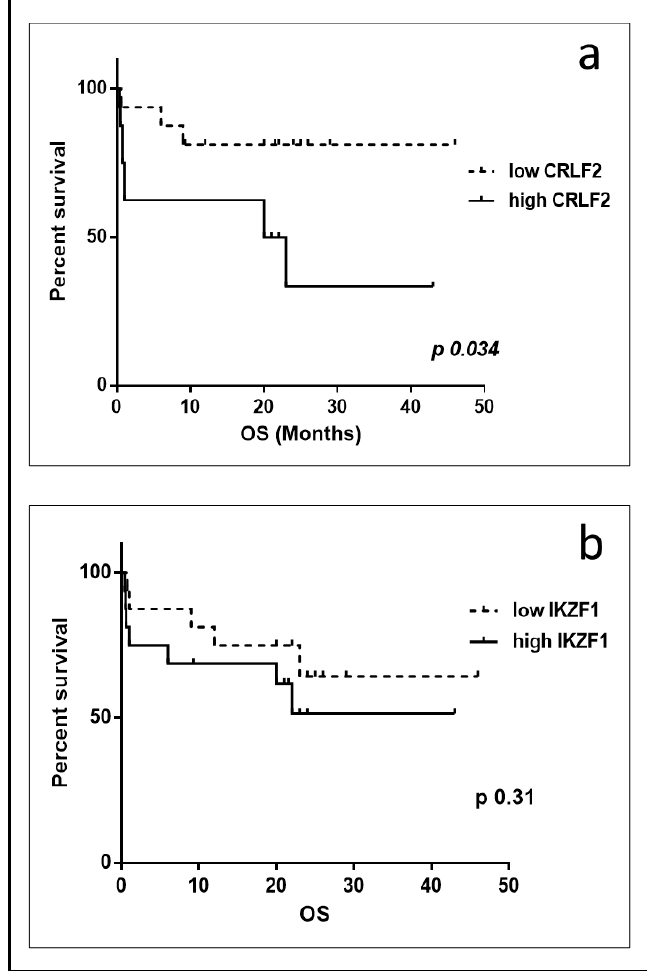
Figure 3: Correlation between CRLF2 (a) and IKZF1 (b) expression and overall survival